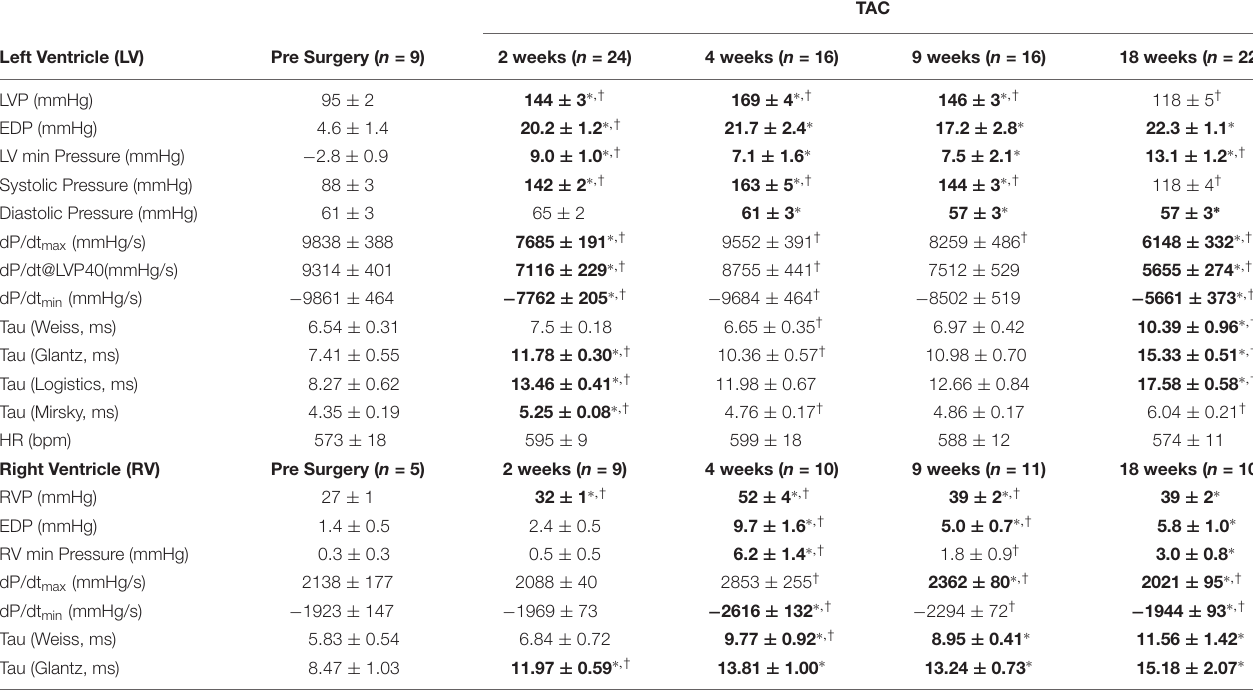
TABLE 1 | Invasive hemodynamics from the left and right ventricles in TAC.